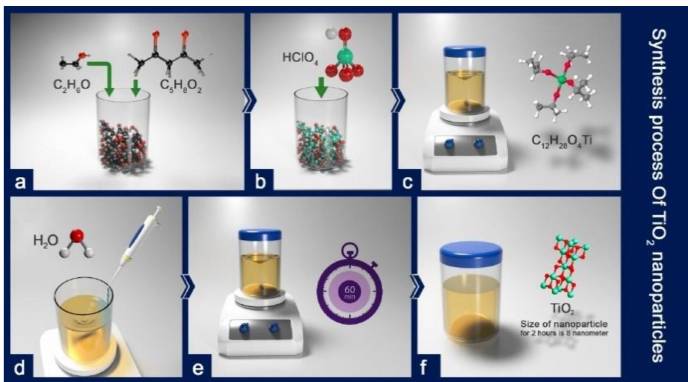
Figure 1. The synthesis of TiO 2 nanoparticles using the sol-gel method: ( a ) mixing ethanol and 2,4-pentanedione; ( b ) adding perchloric acid 70%; ( c ) stirring the solution and adding titanium tetraisopropoxide; ( d ) adding Milli-Q water dropwise; ( e ) stirring the solution for an hour at room temperature; ( f ) the TiO 2 sol gel solution.